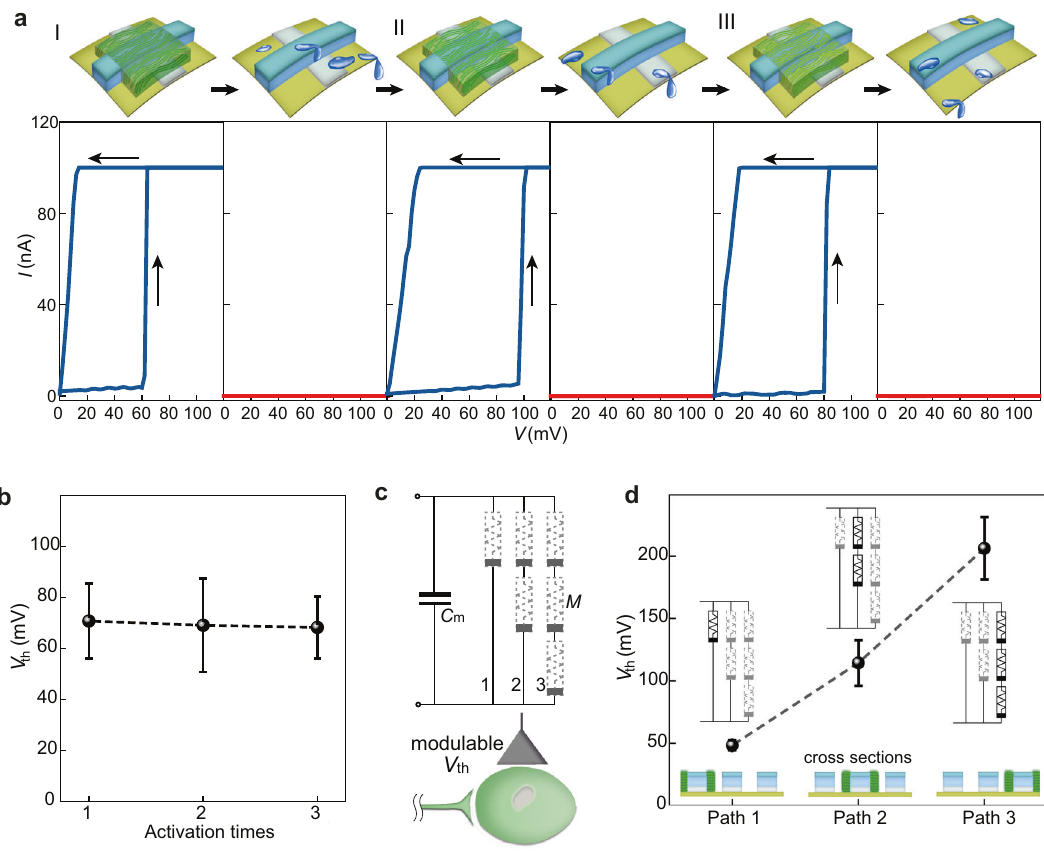
Fig. 4 Recon fi gurable neuromorphic interface. a (Top) Schematics of three consecutive processes of deposit-and-removal protein nanowires in a memristor structure. (Bottom) Corresponding memristive status in the device in each stage. b Average V th ( N = 6) in the three activated stages (i.e., deposited with protein nanowires). c Circuit diagram of a recon fi gurable arti fi cial neuron, with its threshold voltage ( V th ) for neuronal fi ring modulable by activating different paths of memristor arrays ( M ). d Measured V th ( N = 6) in the arti fi cial neuron with different paths of memristor arrays activated. The error bars in the future represent the standard deviation